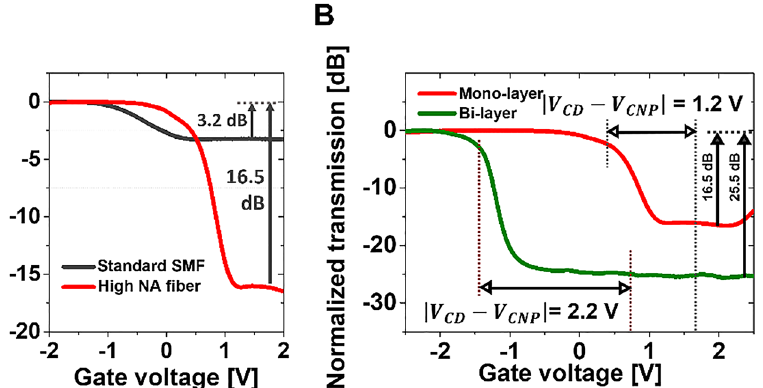
Figure 2: Comparison between the optical responses of (A) monolayer graphene device with a standard single-mode fi ber (SMF) and a high numerical aperature (NA) fi ber and (B) monolayer and bilayer graphene devices with a high NA fi ber as a function of applied gate